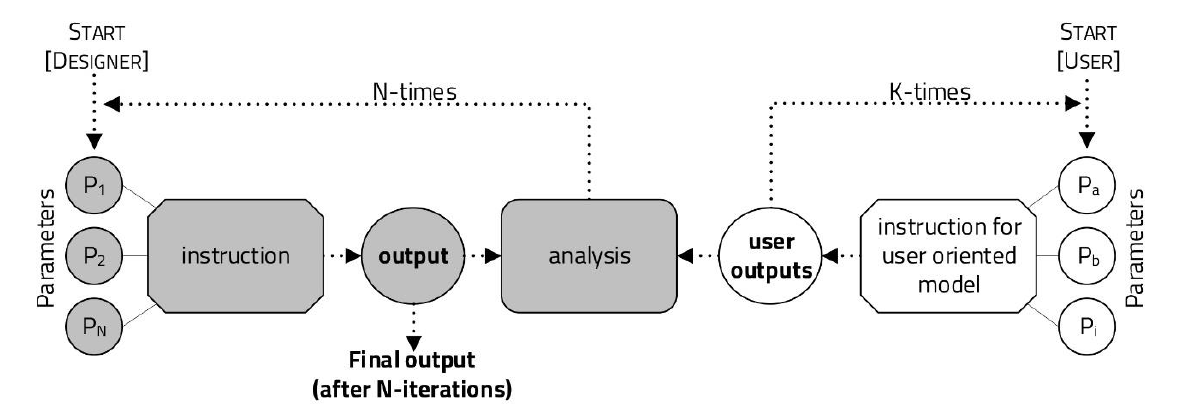
Figure 1 – Proposed design framework. In dark the typical steps of the parametric design process proposed by A. Tedeschi (2014). In white the implementations proposed by the author in which the subjects involved in the partecipation